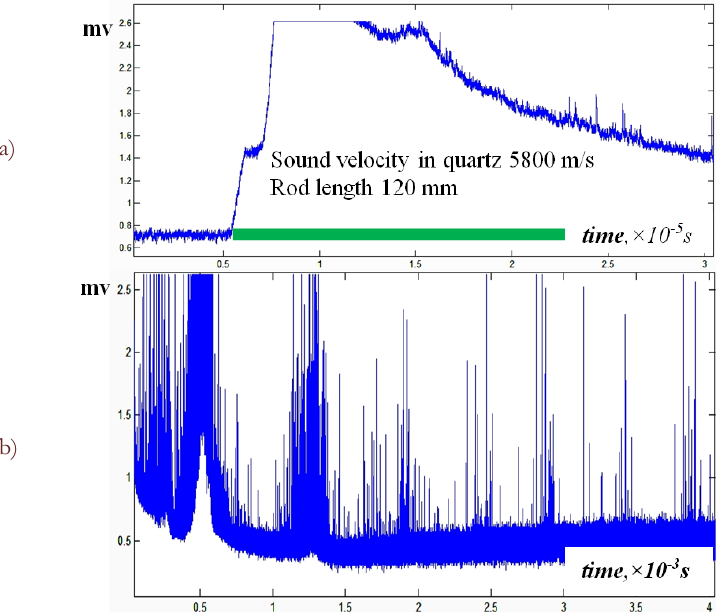
Figure 10: Signal from the oscilloscope corresponding to the intensity of the light reflected from the newly created